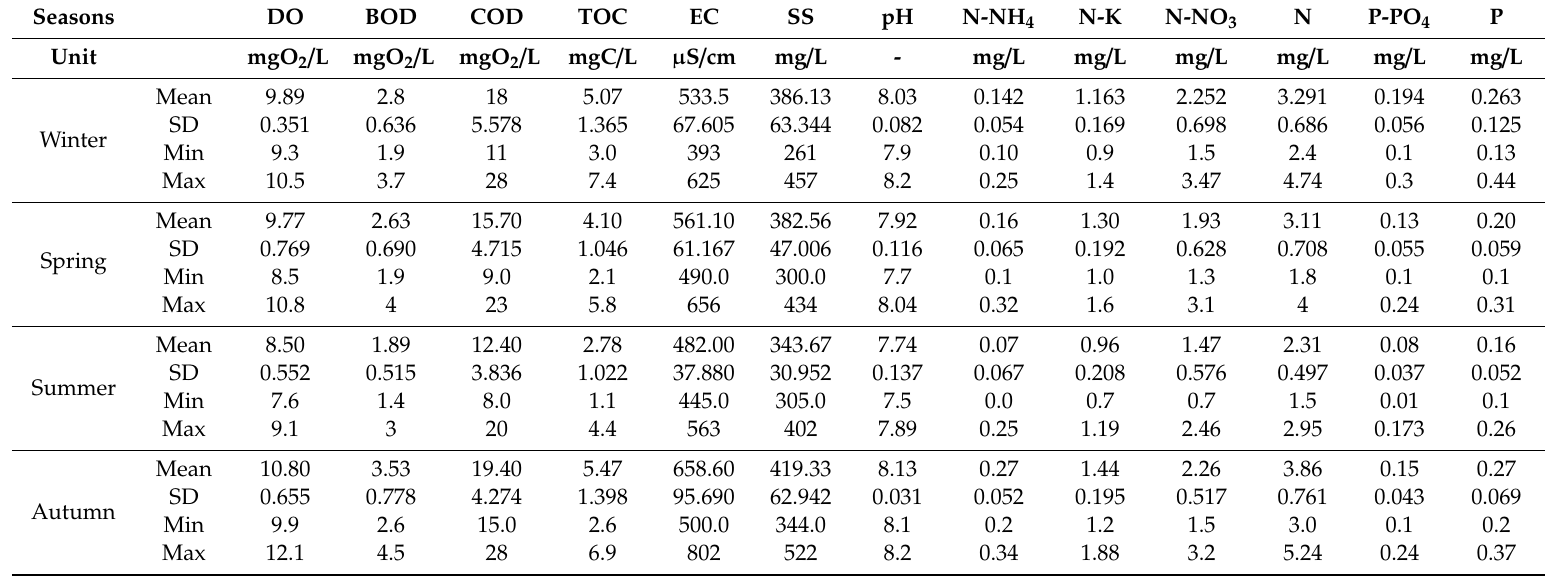
Table 2. Season-specific values of the physical and chemical